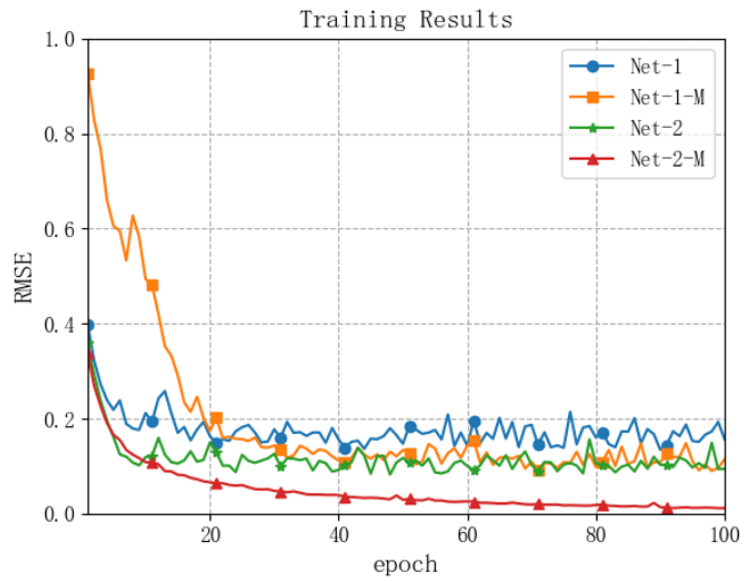
Figure 4. The comparison on RMSE results of Net-1, Net-1-M, Net-2, and Net-2-M. Net-1-M and Net-2-M are the models obtained by Net-1 and Net-2, trained in the multi-branch method, respectively. The parallel multiple convolutions extract different feature maps. Additionally,